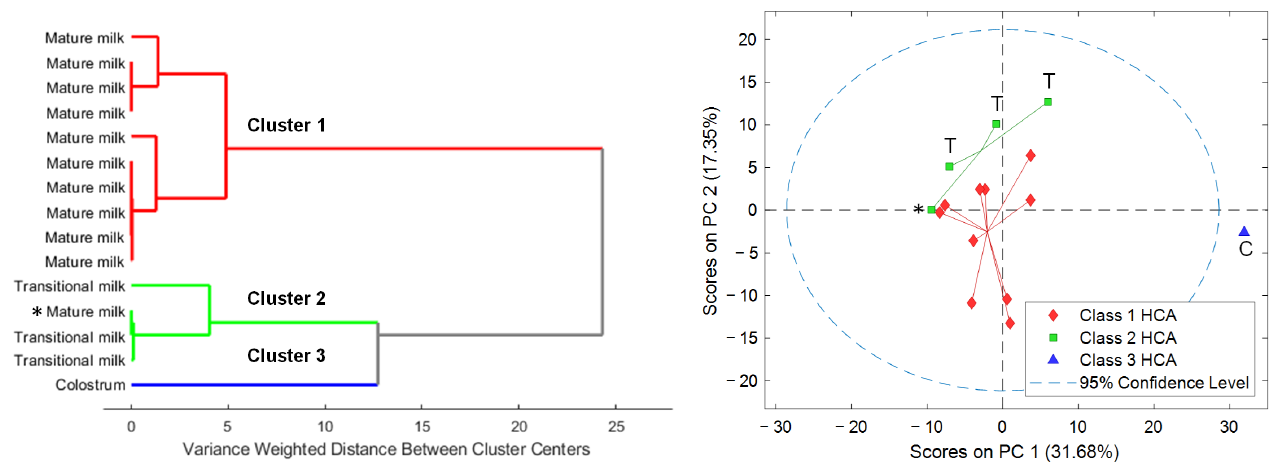
Figure 3. Dendrogram of the HCA (Ward’s method, 1 principal component) of the abundances of different cell types in the HM samples ( left ). PCA scores plot of the metabolomic fingerprints ( right ). Note: Classes 1 to 3 obtained from HCA of HM cell composition. C, colostrum; T, transitional milk; otherwise, mature